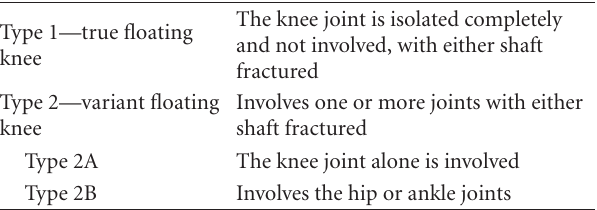
Table 1: Blake and McBryde classification for floating knee